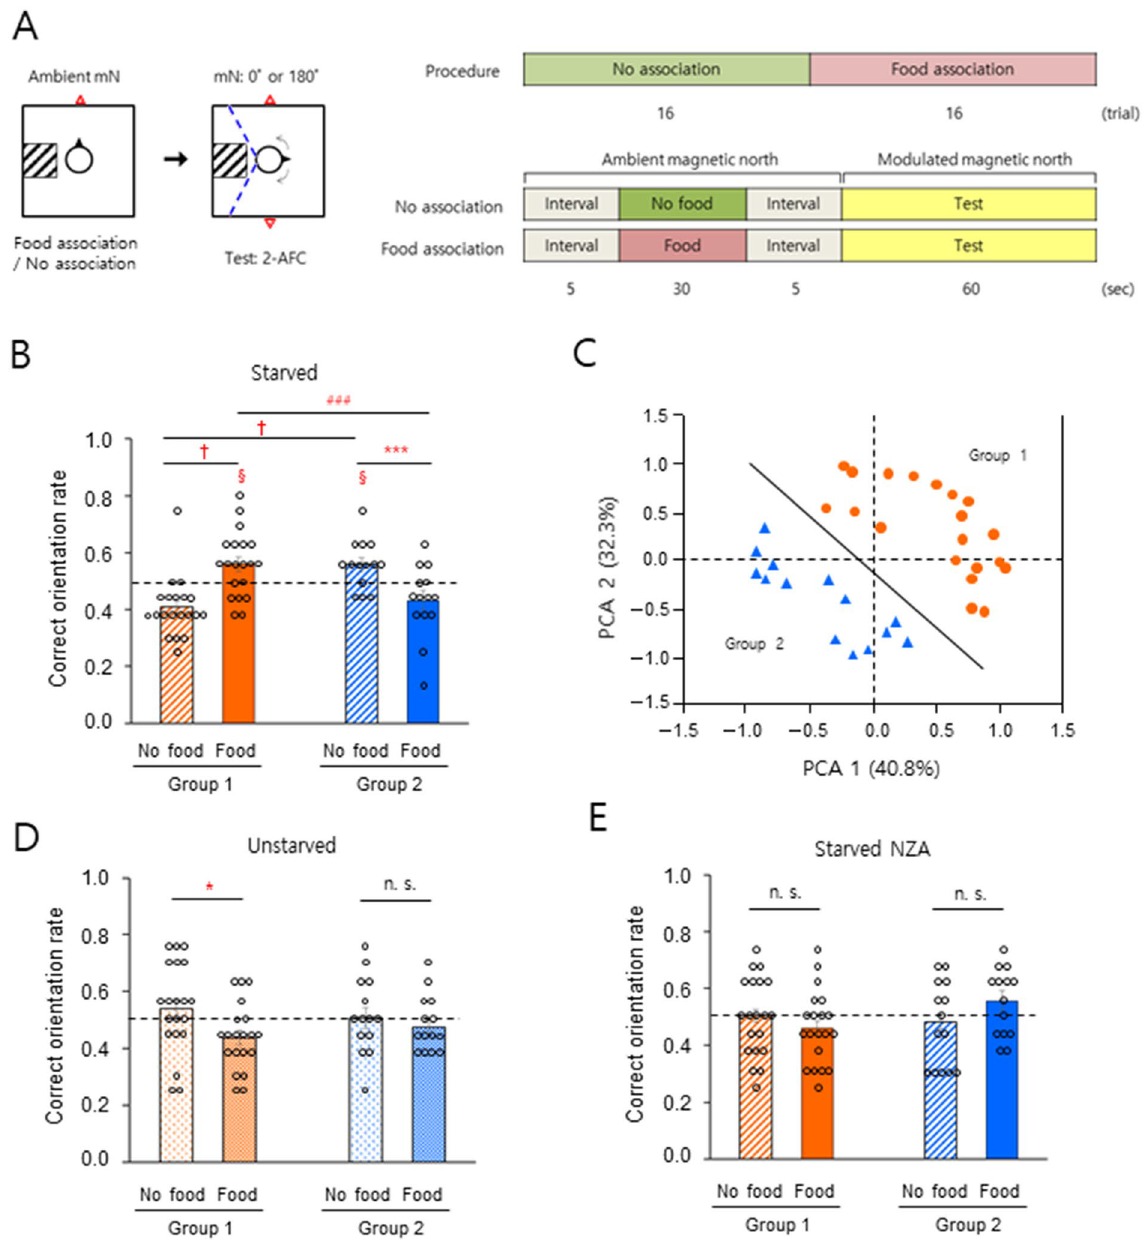
Figure 1. Different sensitivity of geomagnetic orientation in men. ( A ) Schematic drawing of a 2-AFC behavioral paradigm to test geomagnetic orientation in men. Left : Top view of the subject facing toward the ambient geomagnetic north during the no-association/ food-association phase, and rotating to search for one of the two modulated magnetic norths randomly provided during the test phase. Subjects were allowed to rotate clockwise or counterclockwise during the test as shown by arrows within the range indicated by the dashed blue lines (see “Methods” section). mN, magnetic north; square, the vertical Helmholtz coils; square with hatched lines, stool to limit the subject’s rotation; circle, the subject; black closed triangle, the facing direction of the subject; red open triangle(s), direction of the ambient magnetic north (association phase) or modulated magnetic norths (test phase). Right : The procedure and timeline for the 2-AFC experiment. Food was provided for ‘food-association’ trials only. ( B ) A significant increase (Group 1) and decrease (Group 2) in correct orientation rate between the different associations under starved conditions. ( C ) Two subject groups were classified by principal component analysis. Analyzed parameters; correct orientation rate with the food/no-food association under light wavelength of 350–800 nm or 400–800 nm (data, n = 136; 34 subjects). Group 1 (orange filled circle), n = 20; Group 2 (blue filled triangle), n = 14. Solid line, the classifying boundary (PCA 2 = − 1.1515 PCA 1 − 0.0897) ( D ) A significant decrease (Group 1) in correct orientation rate by the change of association under the unstarved condition. ( E ) No notable change of correct orientation rate with near-zero GMF during the association phase. NZA, near-zero GMF association; §, P < 0.05 by one-sample t- test; *, P < 0.05; ***, P < 0.005 and n.s., not significant by paired sample t- test; ### , P < 0.005 by two sample t- test; †, P -value, 0.9999 > 0.9750 (confidence interval, − 0.2170, − 0.0820) for the data of no-association and food-association in Group 1, and 1.0000 > 0.9750 (confidence interval, − 0.0801, 0.0786) for the data of no-association in Group 1 and Group 2 by a percentile bootstrap analysis (see Fig. S2); horizontal dashed lines, 0.5 for correct orientation rate; error bars, standard error of the mean